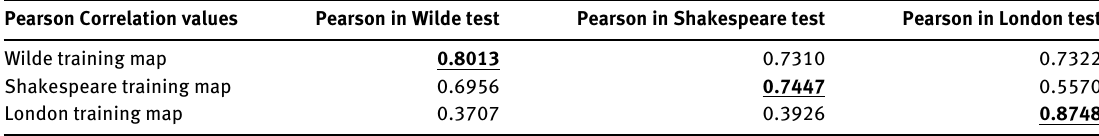
Table 2: Prediction Results Showing Authors’ Training Maps vs. Authors’ Test Books for the Present Research. Pearson Correlation values